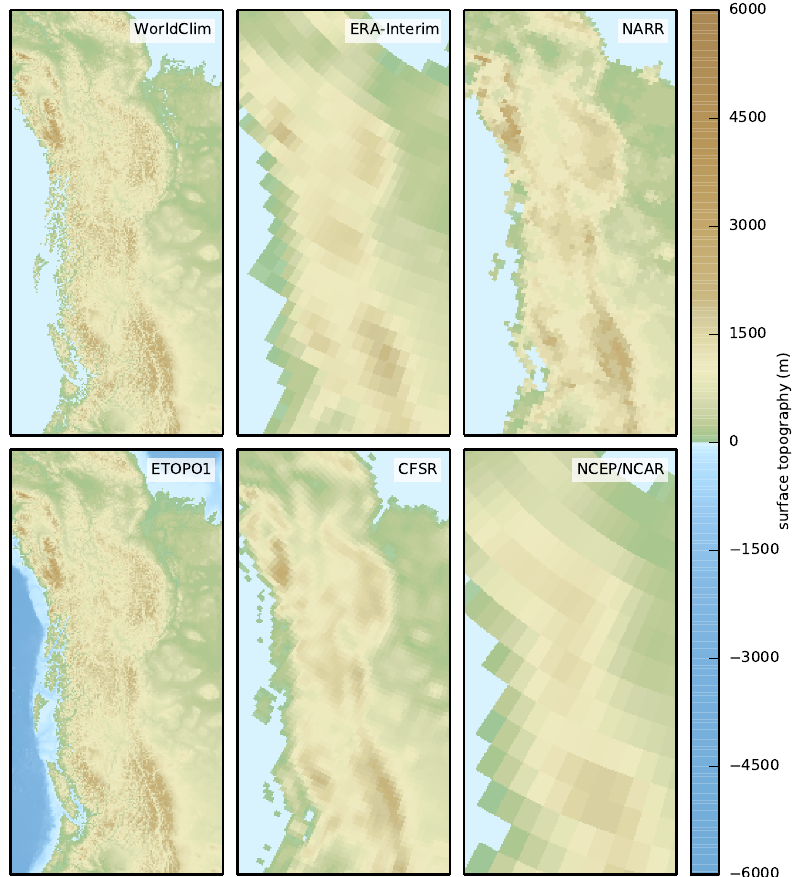
Figure 2. Topography maps from WorldClim (Hijmans et al., 2005), ERA-Interim reanalysis (Dee et al., 2011), North American Regional Reanalysis (NARR; Mesinger et al., 2006), ETOPO1 (Amante and Eakins, 2009), Climate Forecast System Reanalysis (CFSR; Saha et al., 2010), and NCEP/NCAR reanalysis (Kalnay et al., 1996). Whereas ETOPO1 is used as basal topography for the ice sheet model, all other data are used as a reference for temperature lapse-rate corrections. Figures 2–16 are drawn using Matplotlib (Hunter,